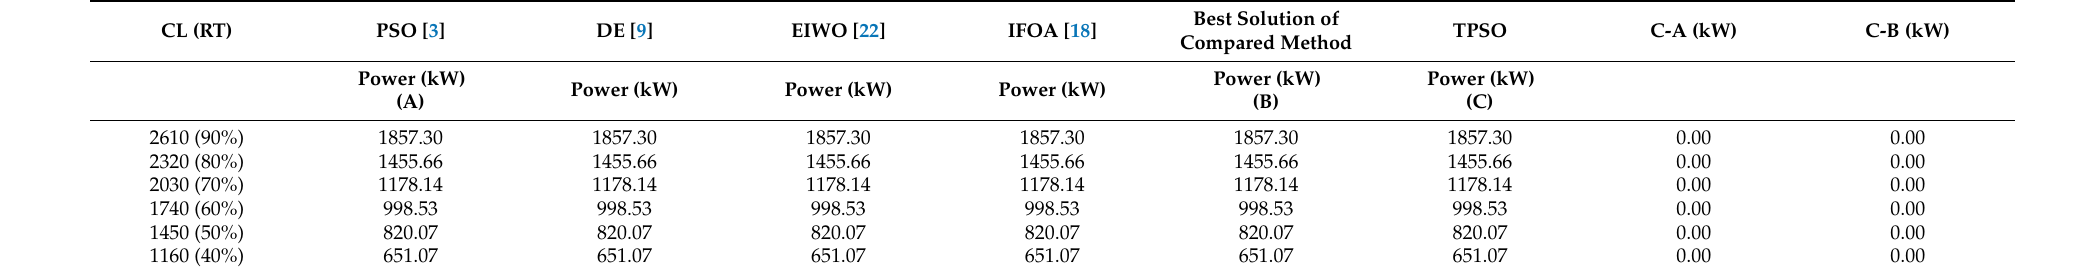
Table 14. Comparison of optimum value operated by TPSO, PSO, DE, EIWO, IFOA in Case 2.